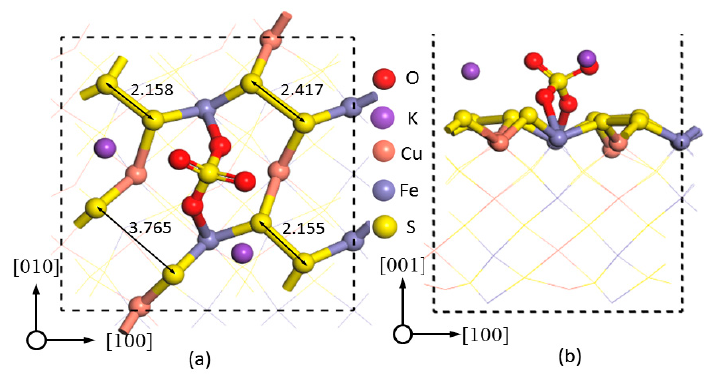
Figure 8. The most stable configuration of K 2 SO 4 adsorbed on the chalcopyrite (001)-S surface: ( a ) top and ( b ) side view in -BB mode. Distances are in angstroms.